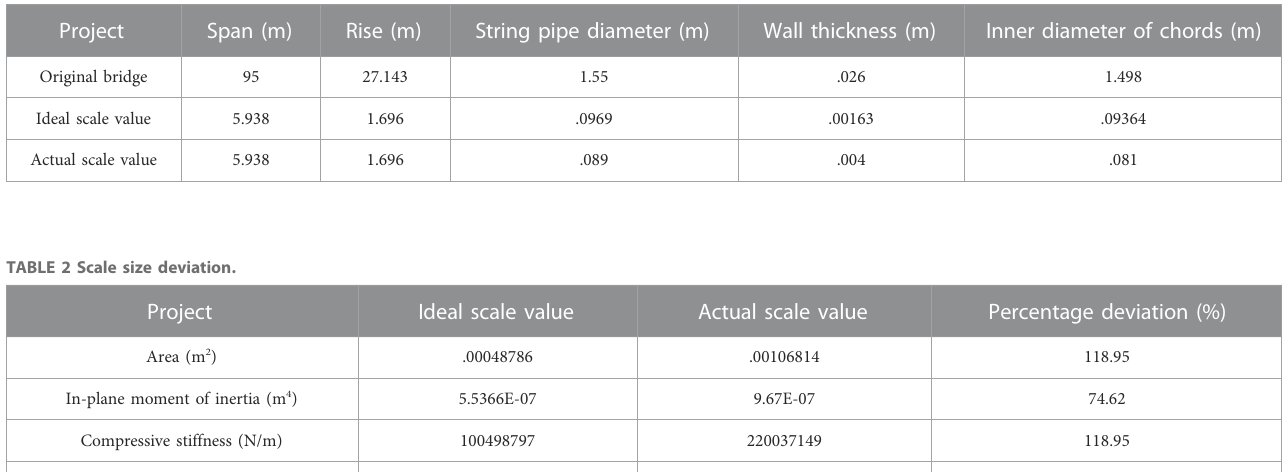
TABLE 1 Parameters of the scaled section.